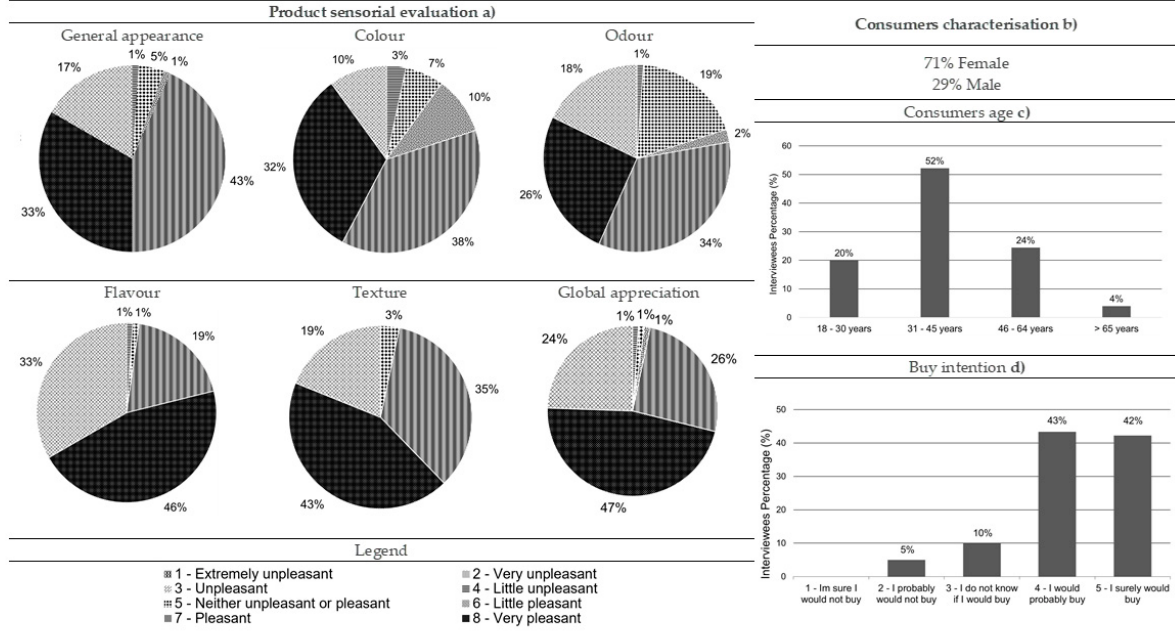
Figure 2. Results from the black seabream ceviche consumer acceptance survey: ( a ) sensorial evaluation (product’s general appearance, colour, odour, flavour, texture and global appreciation), ( b ) consumers characterisation (gender percentage), ( c ) consumers age and ( d ) buy intention ( n = 90).